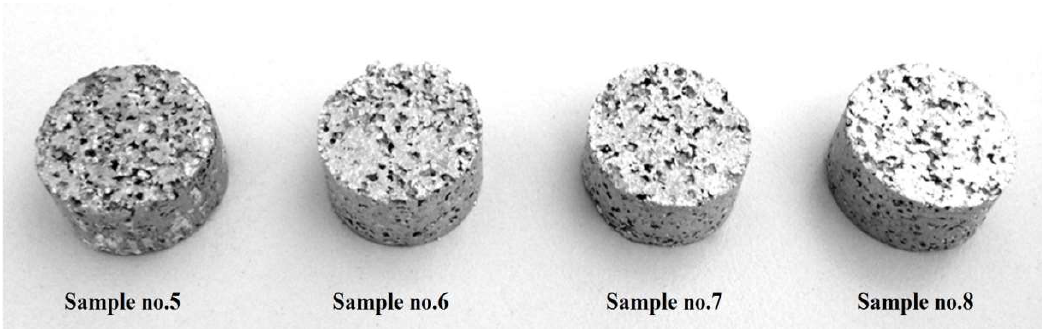
Figure 4. Aluminum foam specimens manufactured with different sintering temperatures.